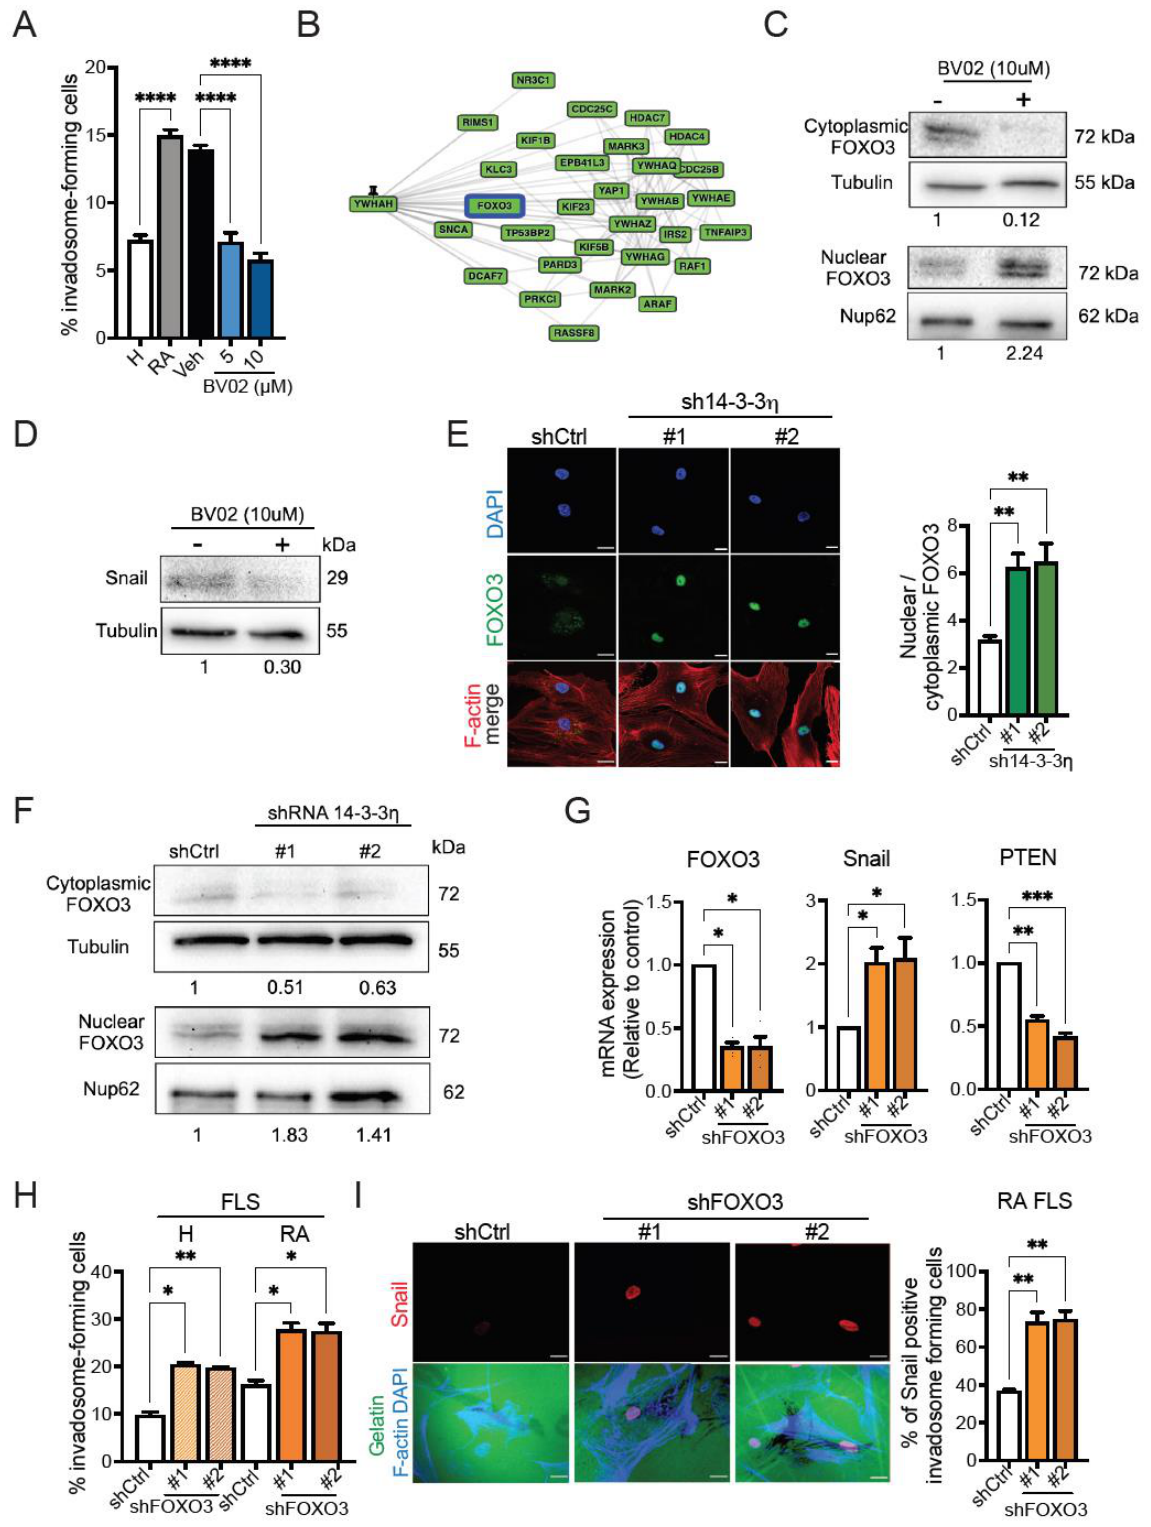
Figure 4. The effect of 14-3-3 η -FOXO3 interaction on invadosome formation and Snail expression. ( A ) H FLS or RA FLS were cultured on Oregon green 488 -conjugated gelatin coverslips for 48 h and treated with BV02 at the indicated concentrations for 48 h. The percentage of